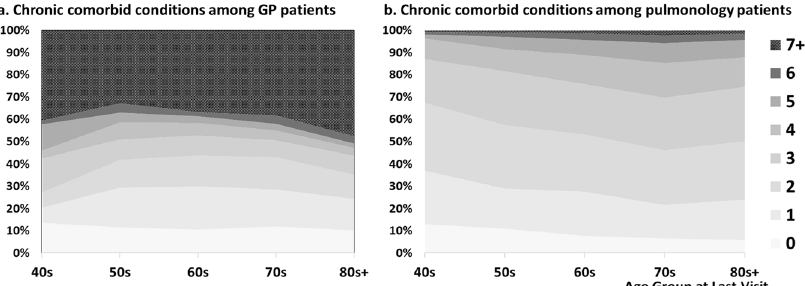
Fig. 3 Percent distribution of patients with a number of chronic comorbid conditions (CCC). Figures represent frequency of patients with a number of comorbidities, from 0 to 7 or more, for each age group separated by practice